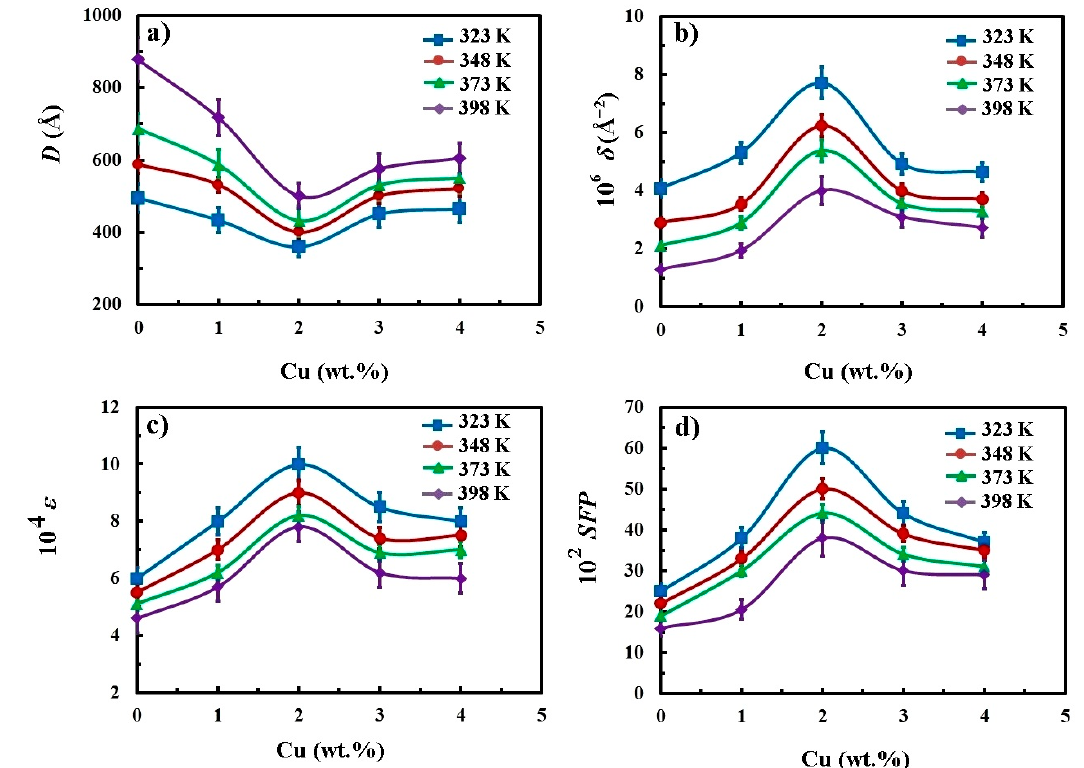
Figure 10. The Cu content dependence of ( a ) average crystallite size, D , ( b ) dislocation density, δ , ( c ) lattice strain, ε , and ( d ) stacking fault probability, SFP , of the investigated alloys at different aging temperatures.